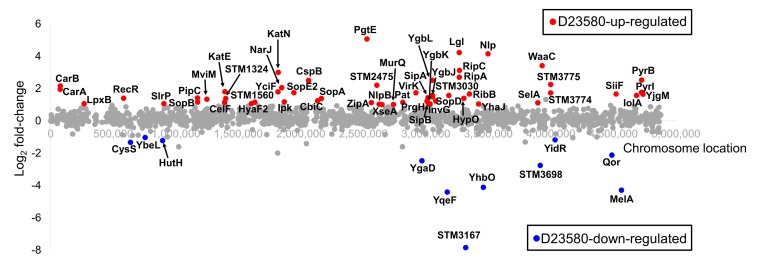
Differentially expressed proteins between S. Typhimurium D23580 and 4/74.Representation of significant D23580-up-regulated proteins (red dots) and D23580-down-regulated proteins (blue dots) in the ESP growth condition by Log2 fold-change and the chromosome location in D23580 (≥2 unique peptides, ≥2 fold-change, p-value <0.05). Gray dots refer to proteins that showed nonsignificant differences. ESP, early stationary phase.